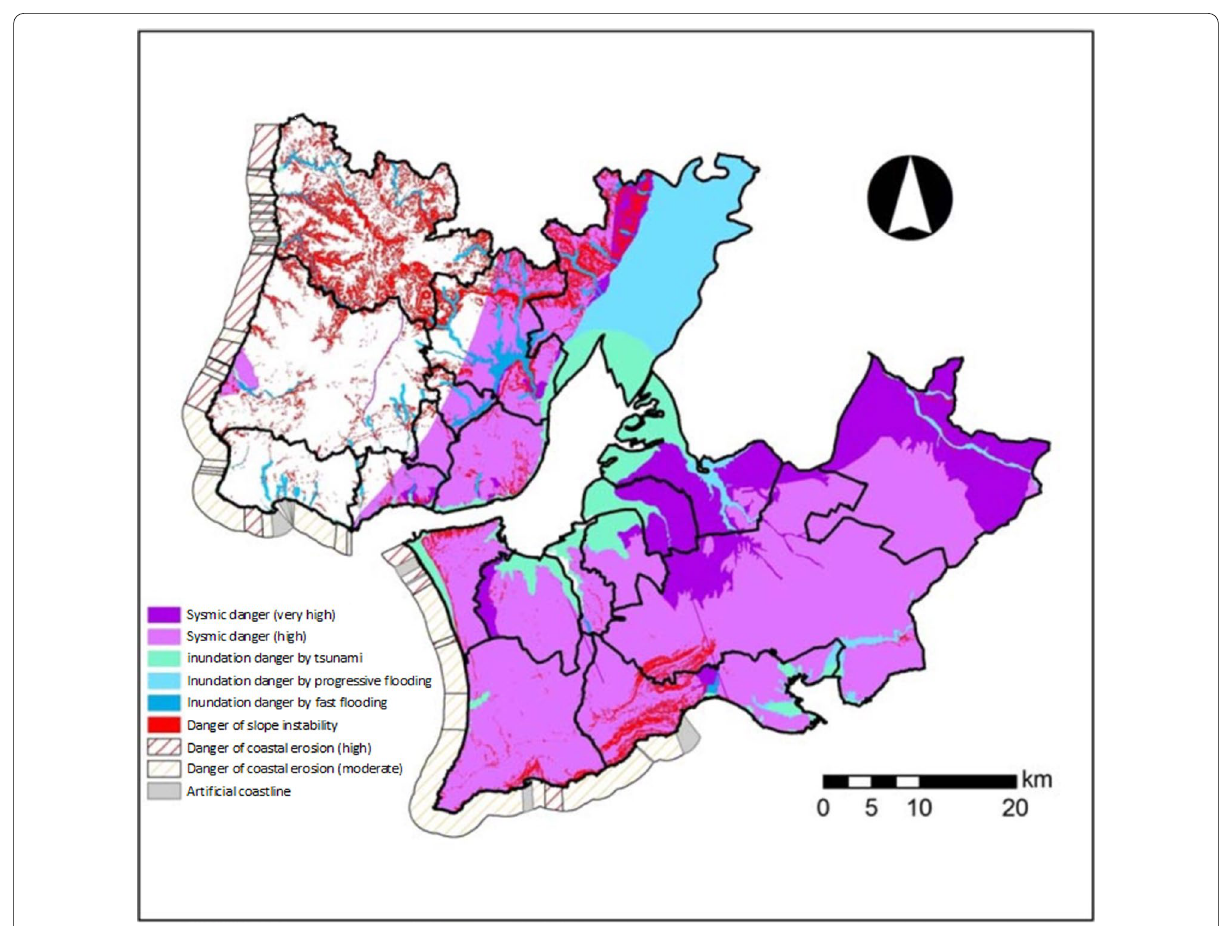
Fig. 1 Lisbon Metropolitan Area, natural hazard map, extracted and translated from